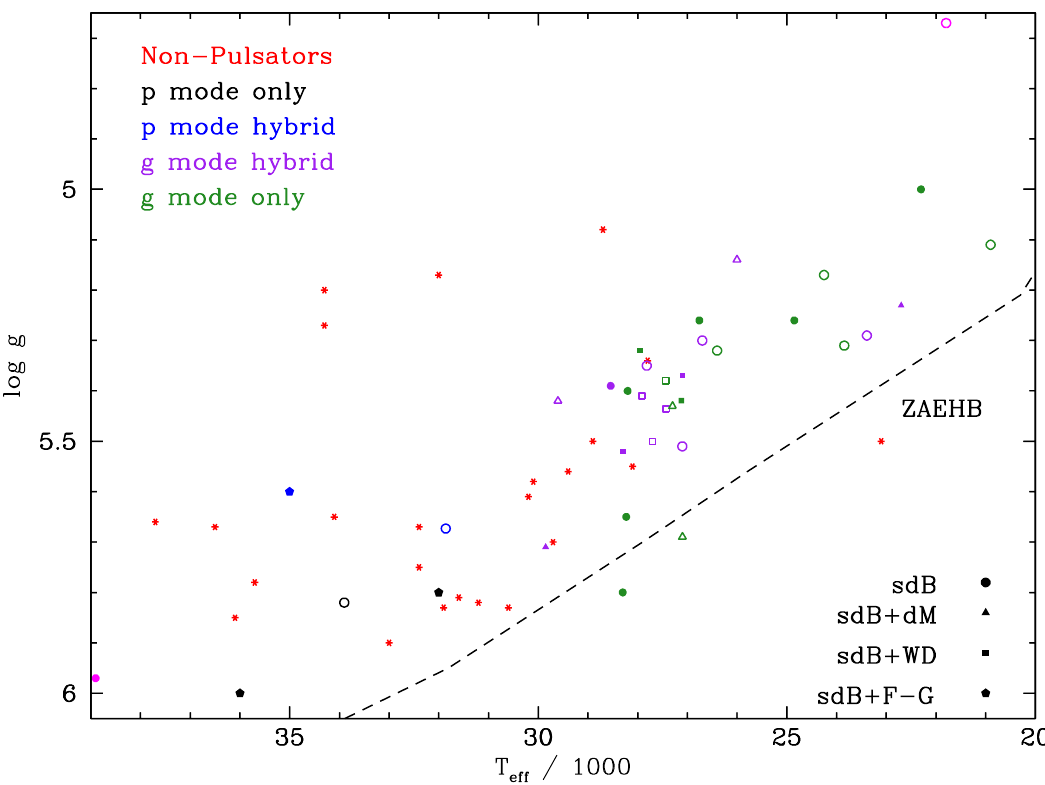
Figure 1. T eff − log g (Kiel) diagrams of sdBV stars. K1 (open points) and K2 (filled points) sdBV stars. Red asterisks are non-pulsators (from Østensen et al. 2010b; Østensen et al. 2011a) and the magenta points are the BHB pulsator of (Østensen et al. 2012a) and the He-sdB pul- sator of (Jeffery et al. 2017). Pulsator colors and point types provided in the figure. The dashed line is the zero-age extended horizontal branch for a total mass of 0.5 M ⊙ with varying envelope